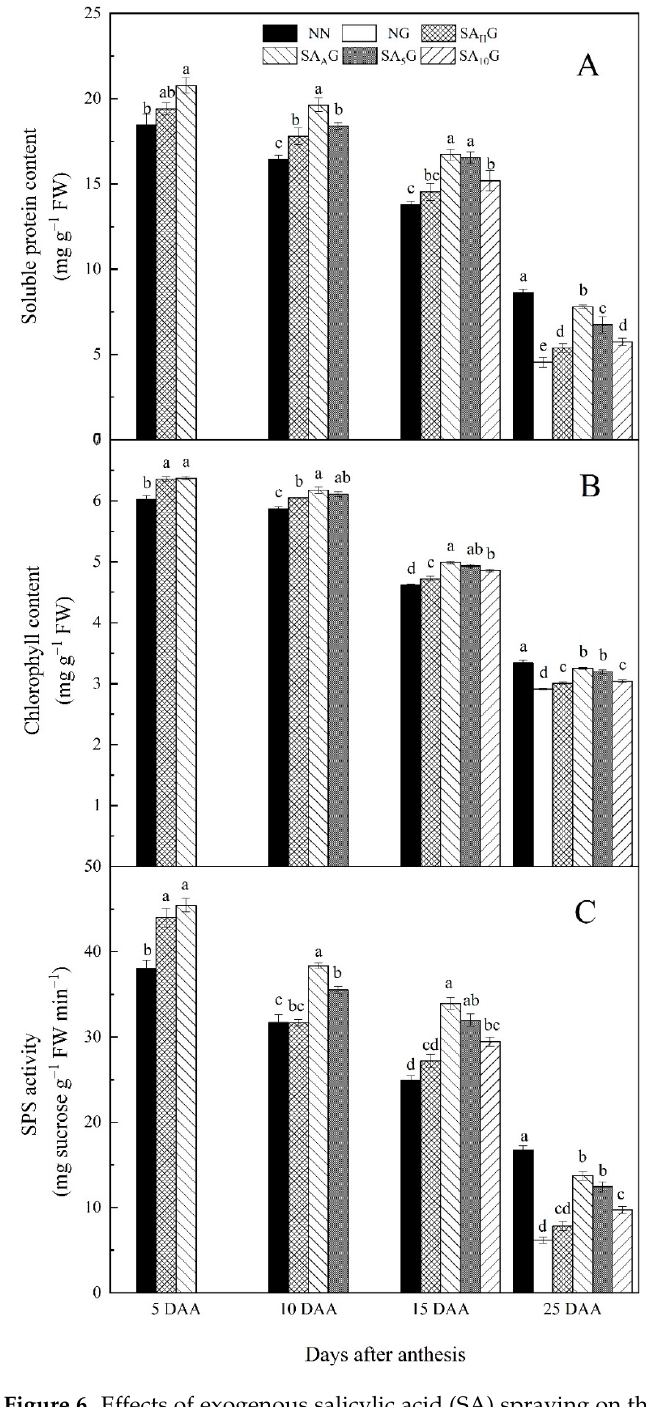
Figure 6. Effects of exogenous salicylic acid (SA) spraying on the chlorophyll content ( A ), soluble protein content ( B ), and sucrose phosphate synthase activity ( C ) of the flag leaves of wheat under high temperature stress during the grain-filling period in 2018–2019. NN is the control (normal growth conditions outside the shed). NG represents non-SA spraying and high temperature stress at the grain-filling stage. SA H G represents exogenous SA spraying at the heading stage and high temperature stress at the grain-filling stage. SA A G represents exogenous SA spraying at the anthesis stage and high temperature stress at the grain-filling stage. SA 5 G and SA 10 G represent treatments whereby exogenous SA was sprayed starting from 5 and 10 DAA and high temperature stress at the grain-filling stage. Different lowercase letters denote statistically significant differences ( p < 0.05, Duncan’s multiple range test) among treatments. Results are expressed as mean ± SE ( n =